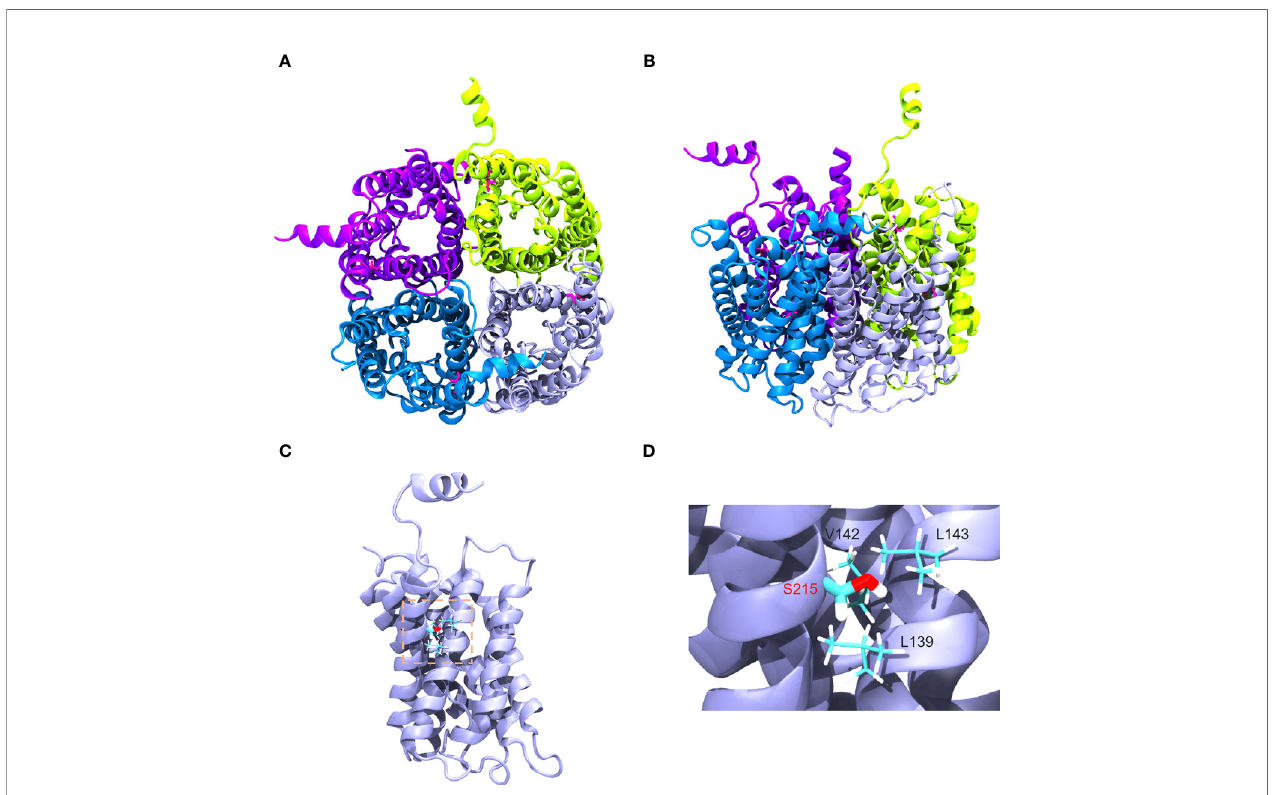
FIGURE 4 | Structural visualization of AQP2 − G215S. (A, B) The structure of AQP2 (PDB ID is 4NEF) was visualized as a tetramer. (C, D) Gly215 was indicated as red in the sixth membrane spanning alpha-helix of the AQP2 monomer as